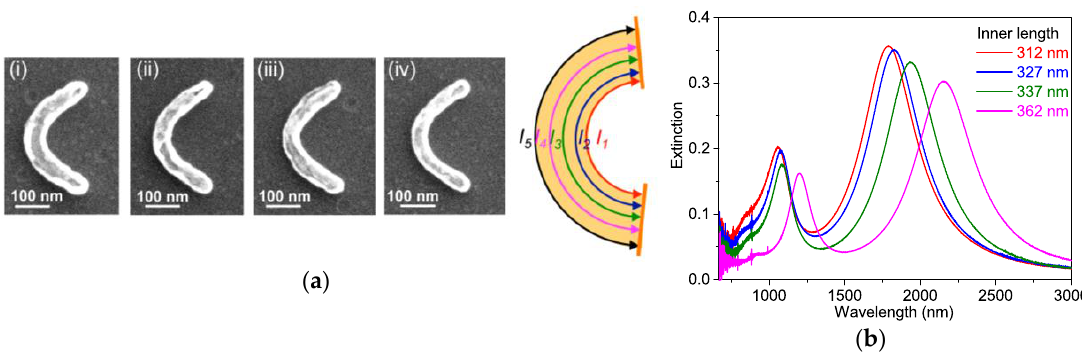
Figure 6. ( a ) SEM images of the fabricated curvilinear nanorods (i)–(iv) with varying inner arc lengths. The design of the inner arc length ( l 1–4 ), and the outer arc length ( l 5 ) of curvilinear nanorods is also shown. ( b ) Extinction spectra of the gold curvilinear nanorods with four different inner arc lengths ( l 1–4 ).